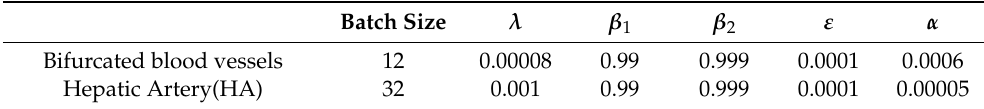
Table 1. Hyperparameters of the optimization algorithm: λ is the regularization coefficient. β 1 , β 2 and ε are the hyperparameters of the ADAM algorithm, α denotes the learning rete.